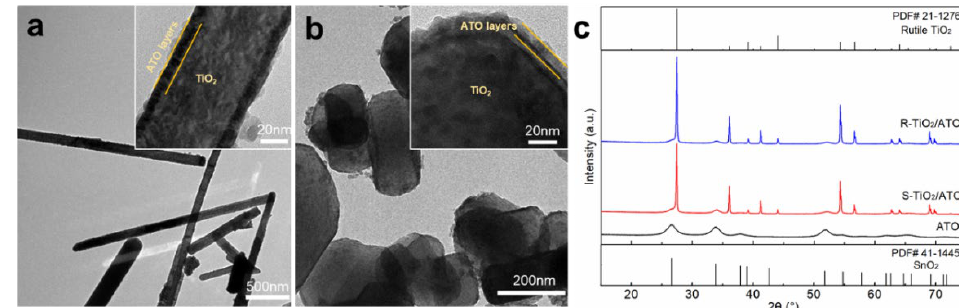
Figure 3. TEM images and XRD patterns. ( a ) TEM of R-TiO 2 @ATO. ( b ) TEM of S-TiO 2 @ATO. ( c ) XRD patterns of TiO 2 @ATO and ATO.